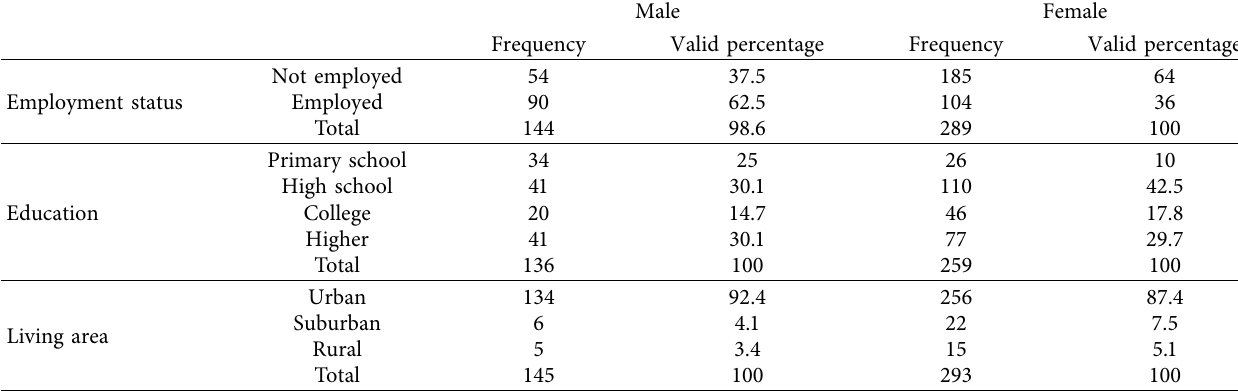
Table 1: Demographic characteristics of participants.